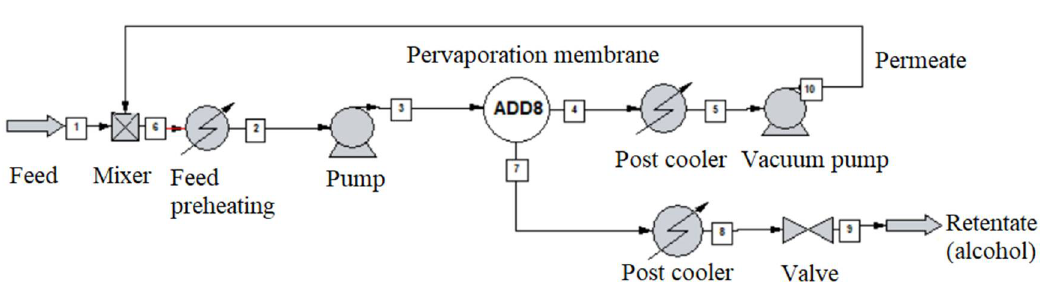
Figure 4. Flowsheet of the recirculating hydrophilic pervaporation method.